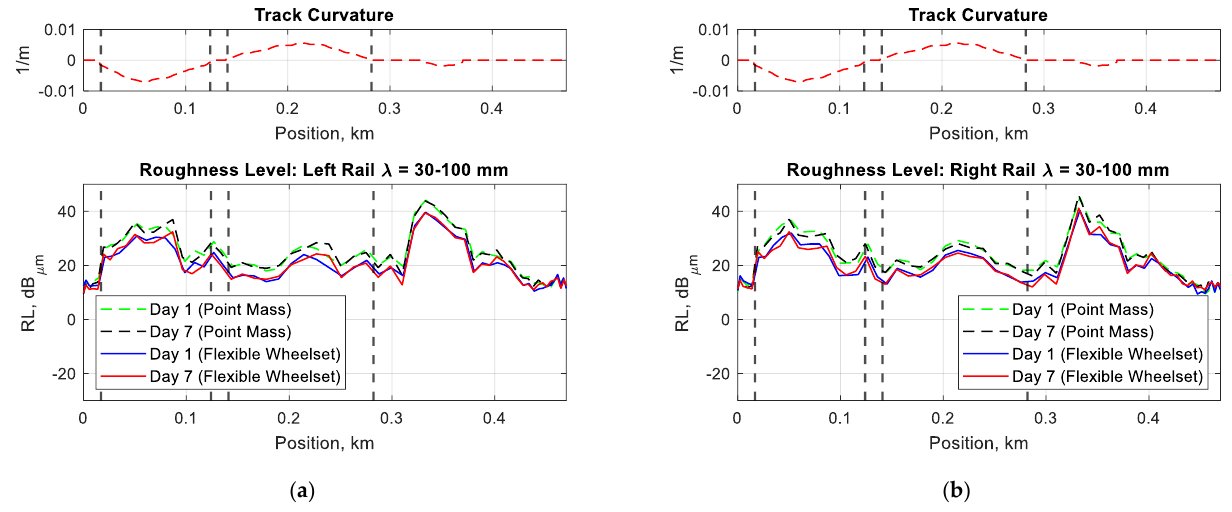
Figure 13. Roughness Level in the 30–100 mm wavelength band: ( a ) left rail; ( b ) right rail.